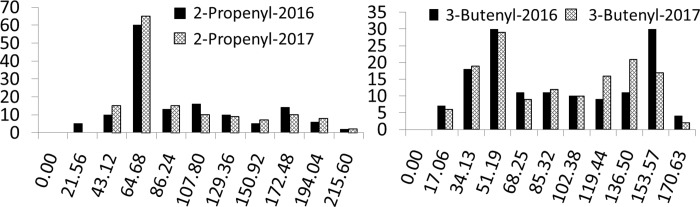
Frequency distribution of 2-propenyl and 3-butenyl glucosinolate content of the recombinant inbred lines (RILs) in 2016 and 2017.Y-axis: the number of the corresponding recombinant inbred lines; X-axis: the glucosinolate content of 2-propenyl (left) and 3-butenyl (right) respectively (u mol/g).